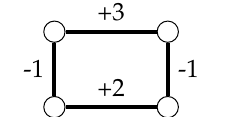
Figure 1. An example of a graph with clique-width 2 and signed clique-width